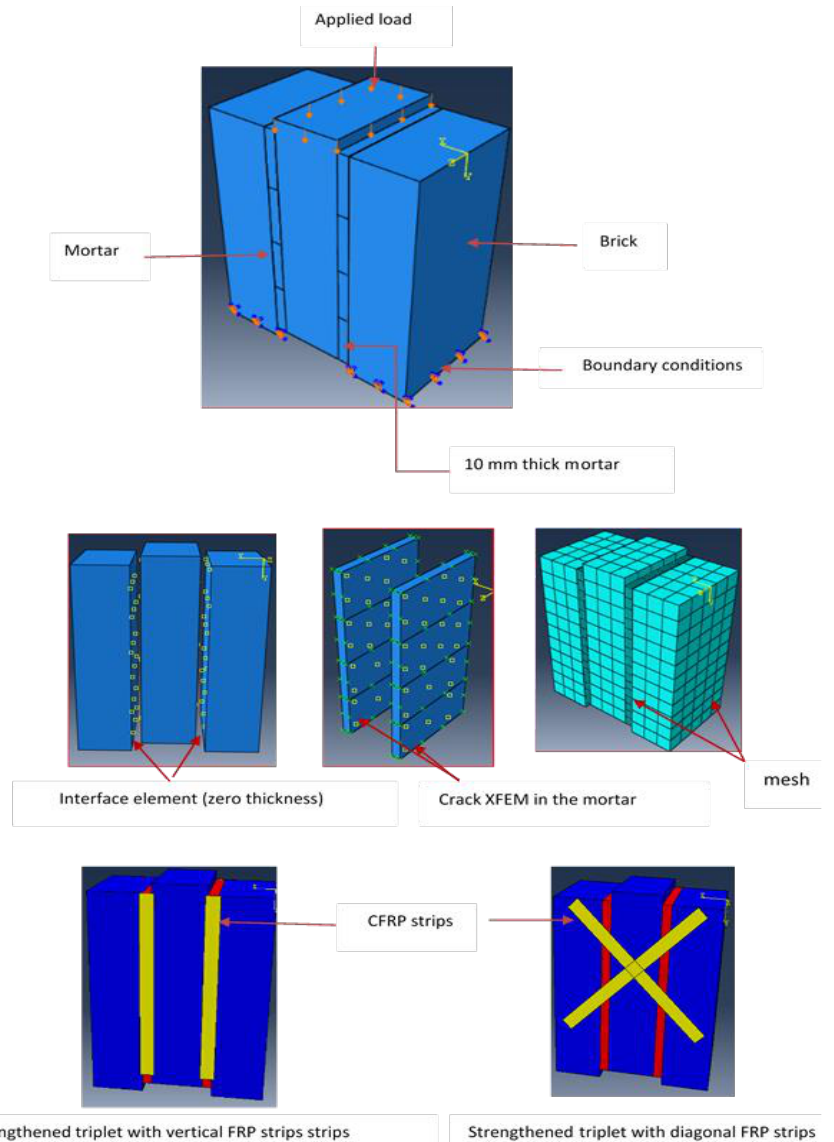
Figure 9. Triplet model with loads and boundary conditions.